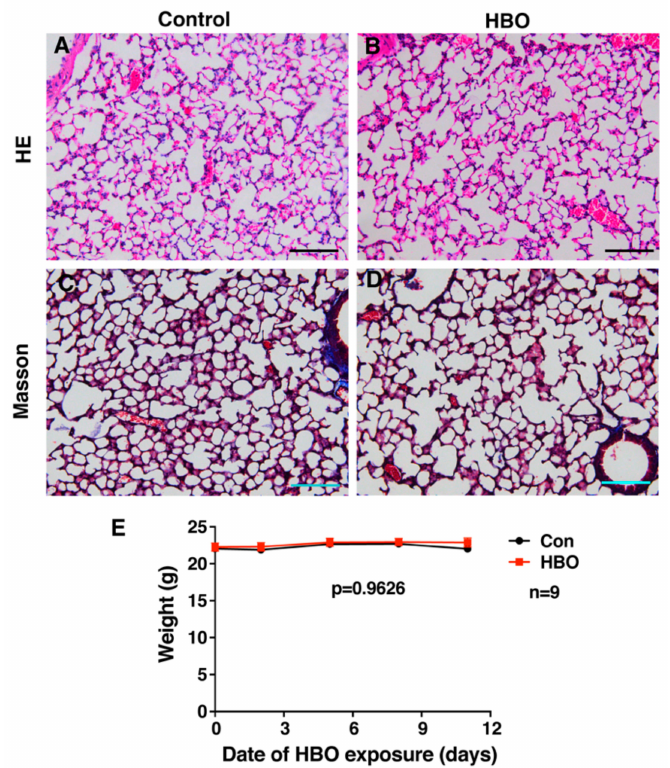
Figure 1. Repetitive HBO exposure had little e ff ect on lung tissue structure and weight. ( A , B ) (top panel) show H / E staining results, ( C , D ) (bottom panel) show Masson’s trichrome staining (collagen shown in blue). ( A , C ) (left panel) show control group, while ( B ,( D ) (right panel) show HBO group. Scale bar represents 100 µ m, n = 4 in control group and n = 5 in HBO group. ( E ) shows control (blue) and HBO-treated (red) mice weight against time, p -value was calculated by two-way ANOVA and the error bars represent standard